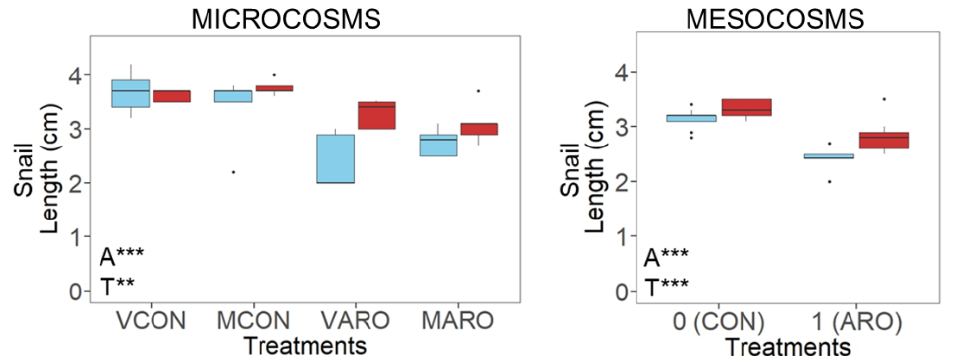
Figure 4. Stressor effects on the final length of snails in the microcosms ( left ) and mesocosms ( right ). Box plots of 5 replicates in the microcosms and 10 replicates in the mesocosms showing the median, 25 and 75% percentiles, lowest and highest whiskers (as Q1 − [1.5 × IQR] and Q3 + [1.5 × IQR], respec- tively), and outliers (dots). Microcosms: VCON = Volvic control; MCON = Munich well water control. ARO; VARO = Volvic ARO; MARO = Munich well water ARO. Mesocosms: 0 (CON) = control in Mu- nich well water; 1 (ARO) = highest ARO concentration in Munich well water. ** p < 0.01; *** p < 0.001. The highest Daphnia numbers are reached during week 2 with the controls showing 82% more individuals L − 1 than the ARO (Figure 5). By the end of the 4-week exposure, the numbers in the controls reduced from 1213 ± 883 to 345 ± 329. Daphnia were controlling the phytoplankton top-down, over time in the controls. While ARO significantly sup- pressed D. magna development during all 4 weeks, it significantly promoted phytoplankton development from weeks 2 to 4. The total average biomass of Daphnia in the controls at the end of the experiment was 73% higher compared with the ARO. Temperature effects on plankton were measurable only in week 1, with an increase in both Daphnia numbers (Figure 5) and phytoplankton (Figure